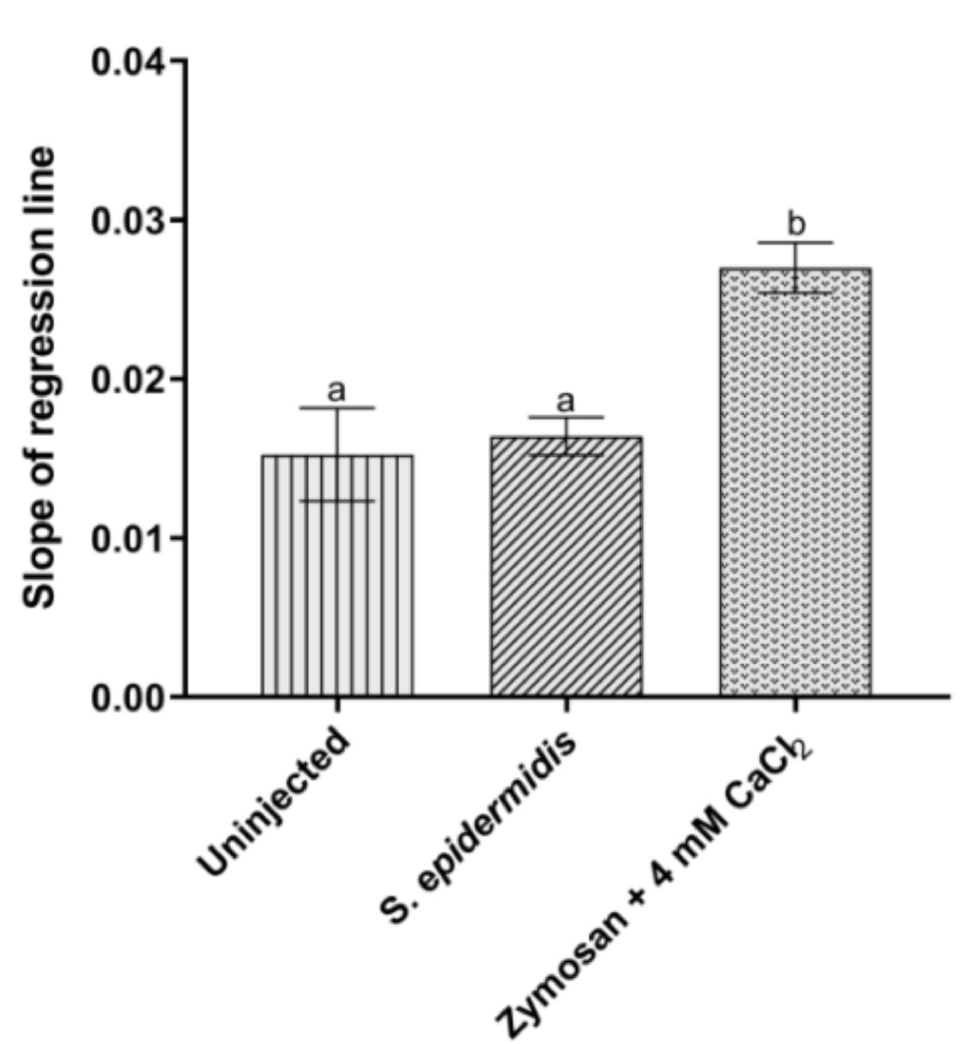
Figure 4. Analysis of proPO system activation. Values represent mean ± s.e.m. Different letters indicate statistically significant differences among treatments ( p <